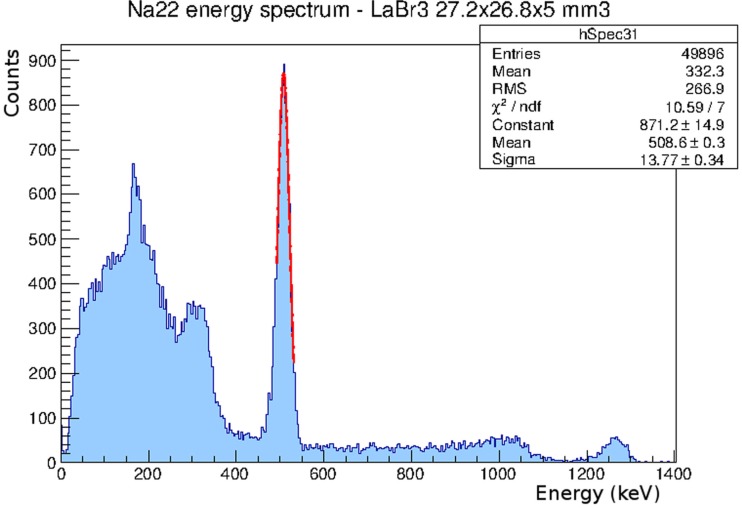
22Na energy spectrum obtained with the first detector. The energy resolution is 6.4% FWHM at 511 keV.